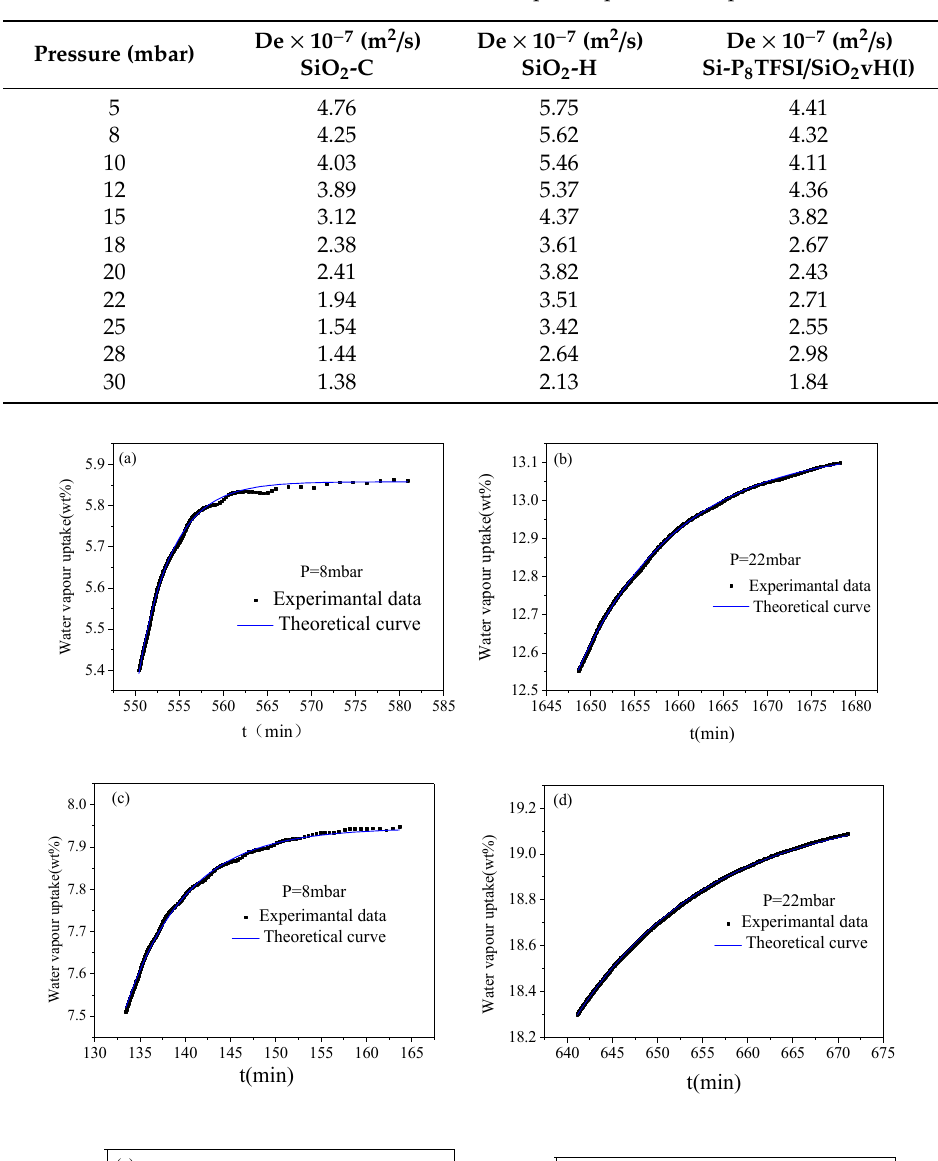
Table 3. The di ff usion coe ffi cient of water vapor sorption in samples at 25 ◦ C.